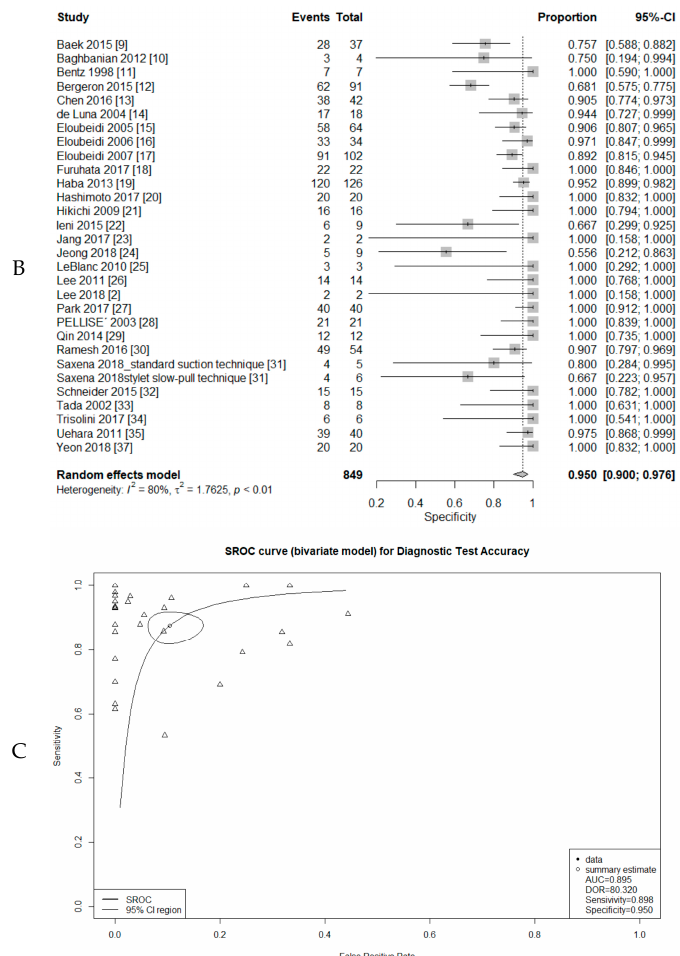
Figure 2. Forest plot diagram of the pooled sensitivit y ( A ), specificity ( B ), and summary receiver operating characteristic (SROC) curve ( C ) in the conventional smear. (Triangle, estimate of each study)